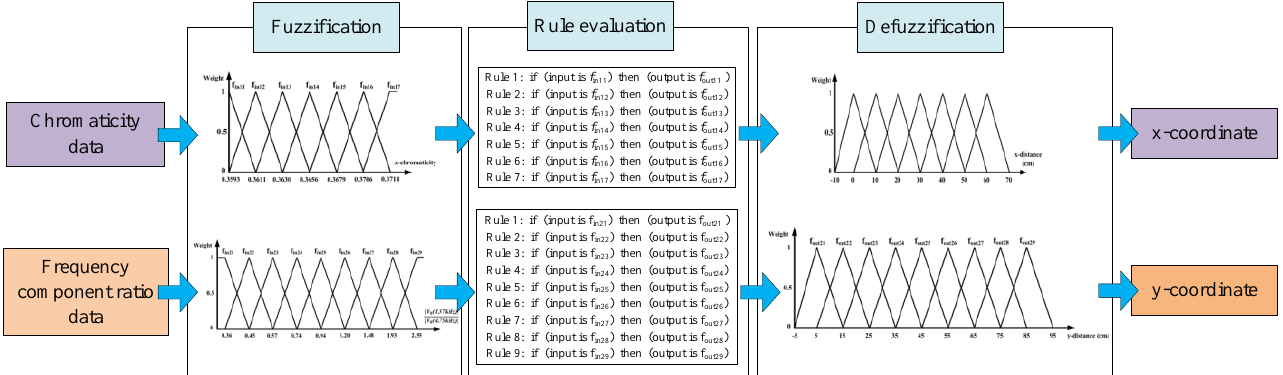
Figure 4. Schematic of fuzzy positioning system [24].